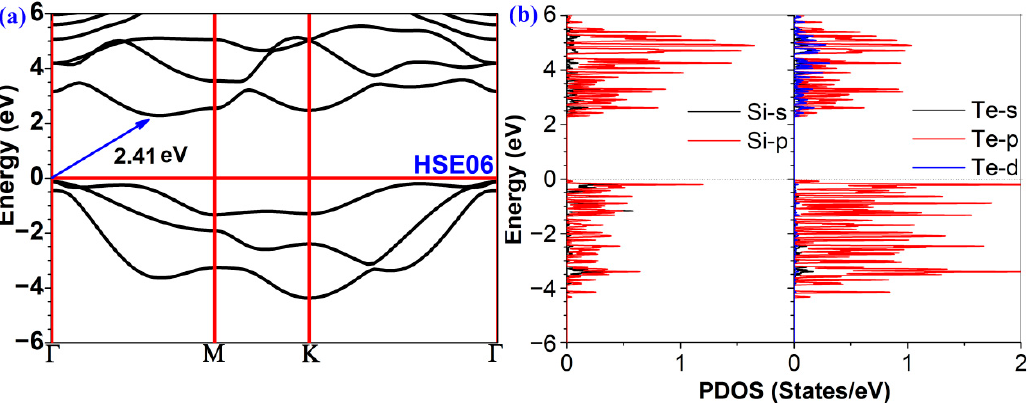
Figure 2. ( a ) The band structures and ( b ) the partial density of states (PDOS) of 2D polar monolayer SiTe.